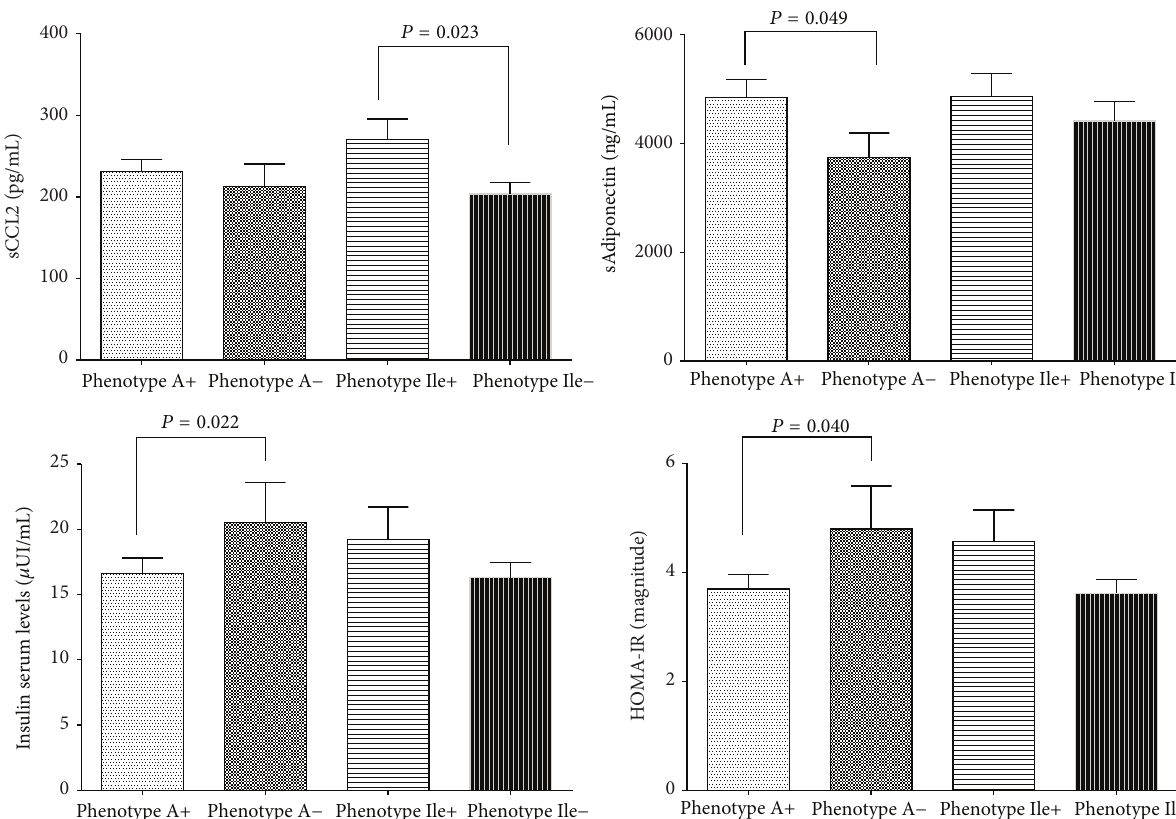
Figure 2: Soluble levels of adipokines, insulin, and HOMA-IR by CCL2 G-2518A and CCR2 Val64Ile phenotype carriers. 𝑛 = 380 . A+ phenotype: A/A plus G/A genotypes; Ile+ phenotype: Ile/Ile plus Val/Ile genotypes. Student’s 𝑡 -test with 𝑃 significantly, comparing the polymorphic phenotype carriers versus wild-type phenotypes carriers.